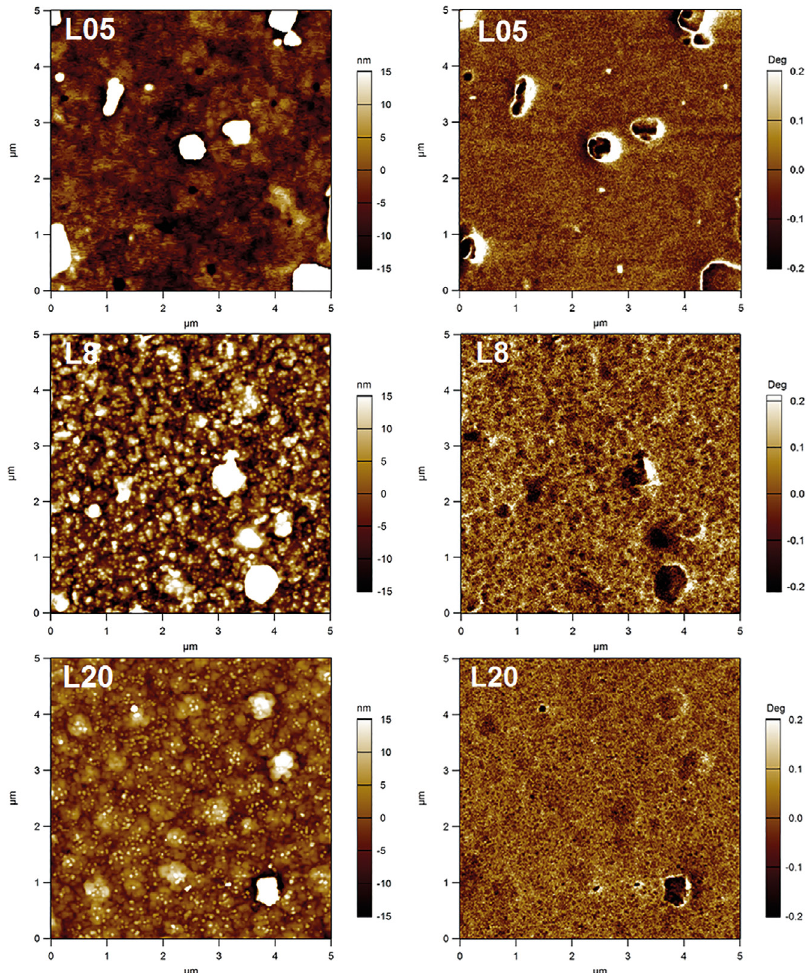
Figure 2. Images showing the topography obtained by AFM (left column) and the mapping of charge conduction, obtained by phase EFM (right column), for 5μm x 5μm regions of the LCMO top